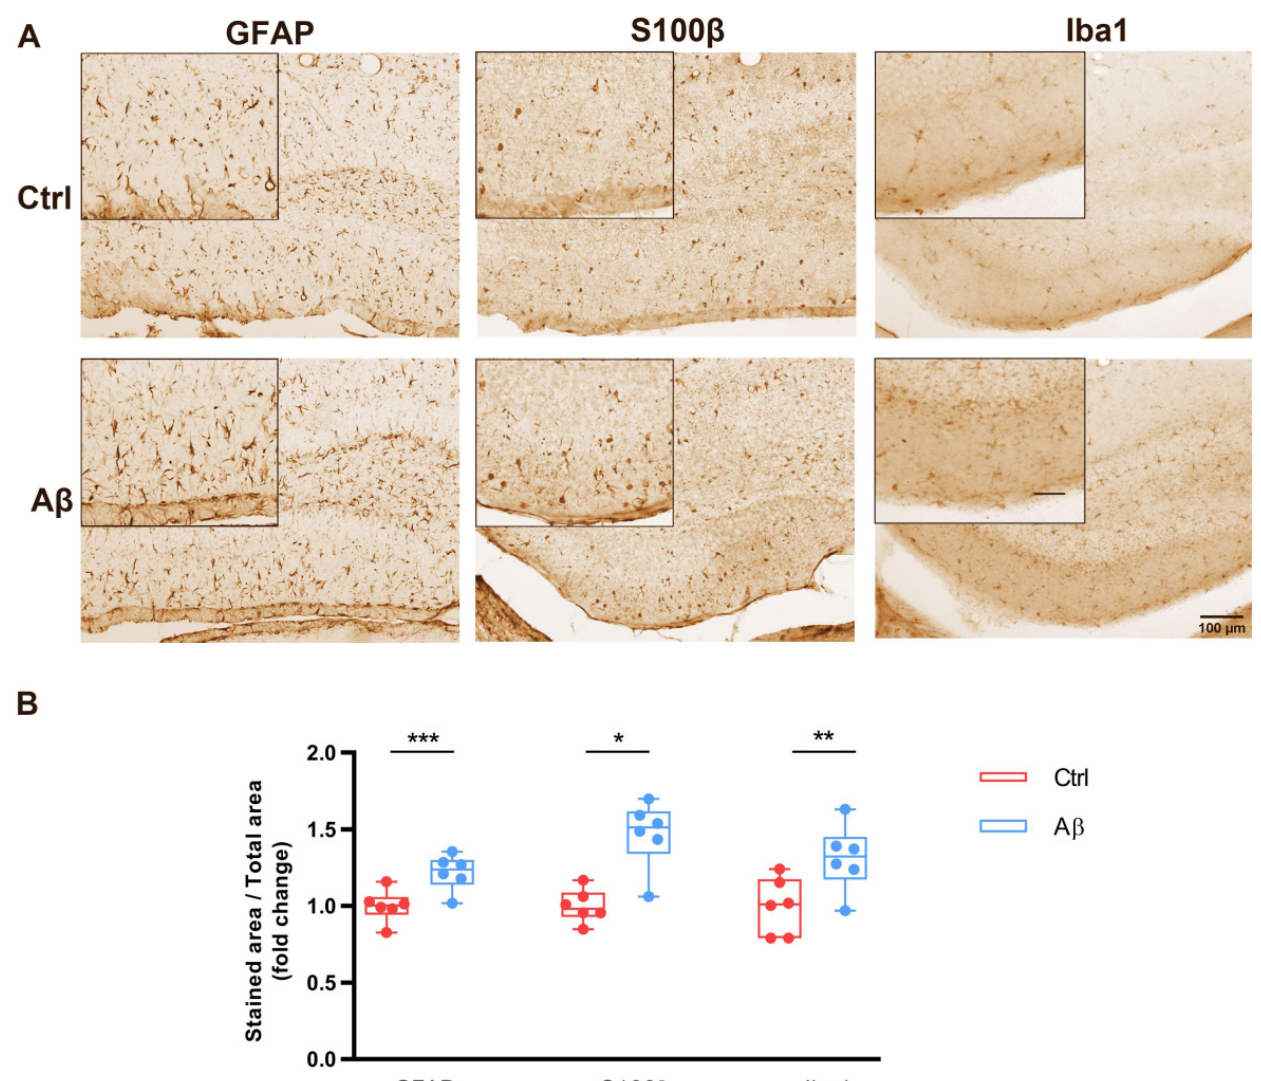
Figure 2. Reactive astrocytes and microglia in the dentate gyrus (DG) of A β -injected mice. ( A ) Coronal sections of mouse brains were immunostained by DAB assay 7 days post -injection with A β or with vehicle (Ctrl). Photomicrographs show GFAP and S100 β immunolabeling in astrocytes and Iba1 immunolabeling in microglia of the dentate gyrus . Scale bar: 100 µm and Scale bar in zoom is 50 µm. It is included in caption.Inset: 50 µm. ( B ) Box plot graphs show quantitative analysis of labelled areas for GFAP, S100 β and Iba1 under A β and control conditions in the DG. Data are presented as the mean ± S.E.M. Fifteen slices from five animals were analyzed per condition. *** p < 0.001, ** p <